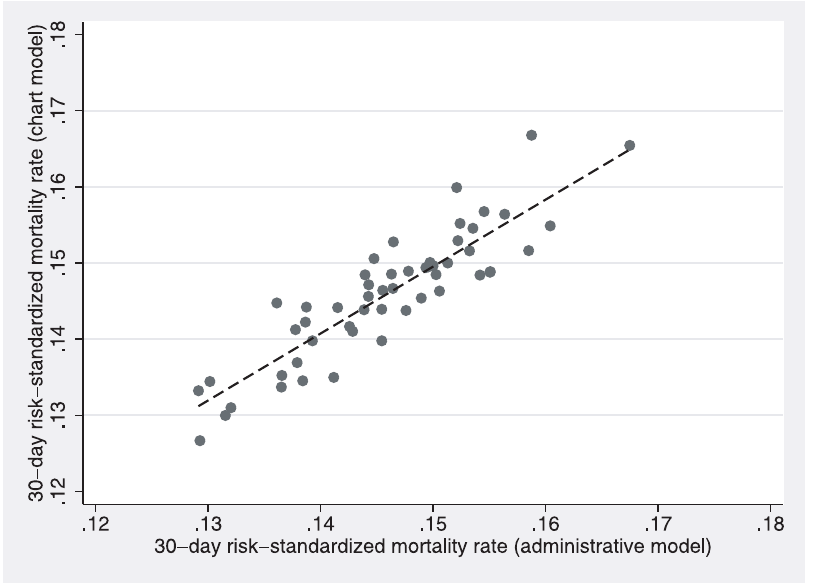
Figure 3. Comparison of the state-level risk-standardized mortality rates generated by the medical record model and the administrative model. Risk-standardized mortality rates were generated with both models for the 50,858 patients in the chart model derivation cohort. The correlation coefficient for rates generated by the 2 models is 0.86 (Standard Error=0.032).